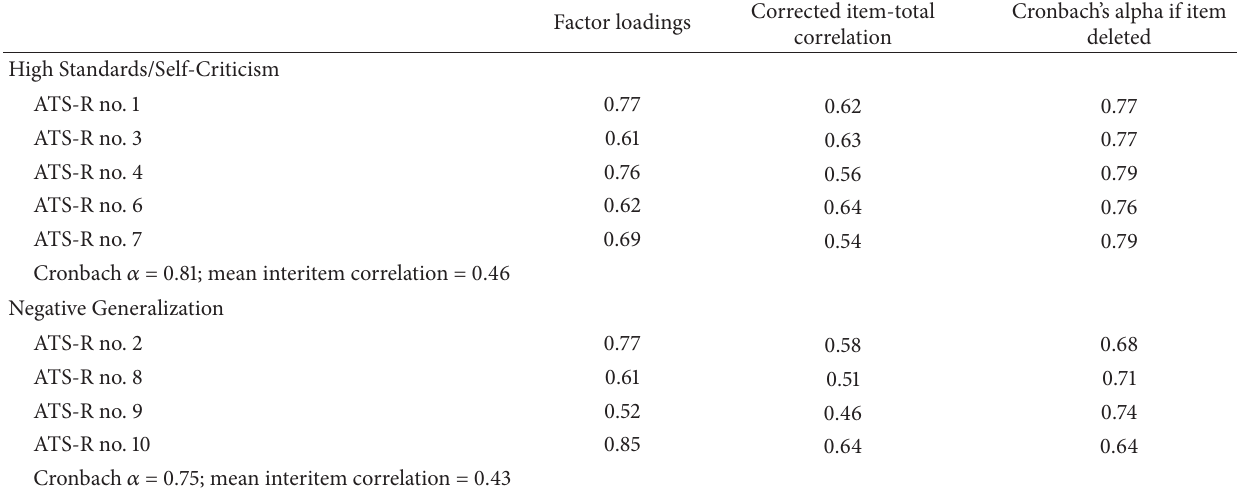
Table 1: Factor loadings and reliability